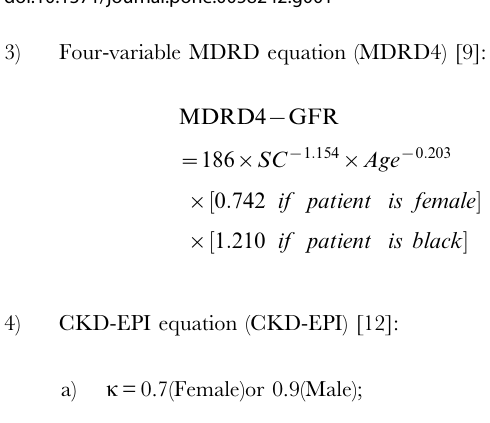
Quantitative data were expressed as mean 6 SD or as median. The difference between eGFR and standard GFR (sGFR) was